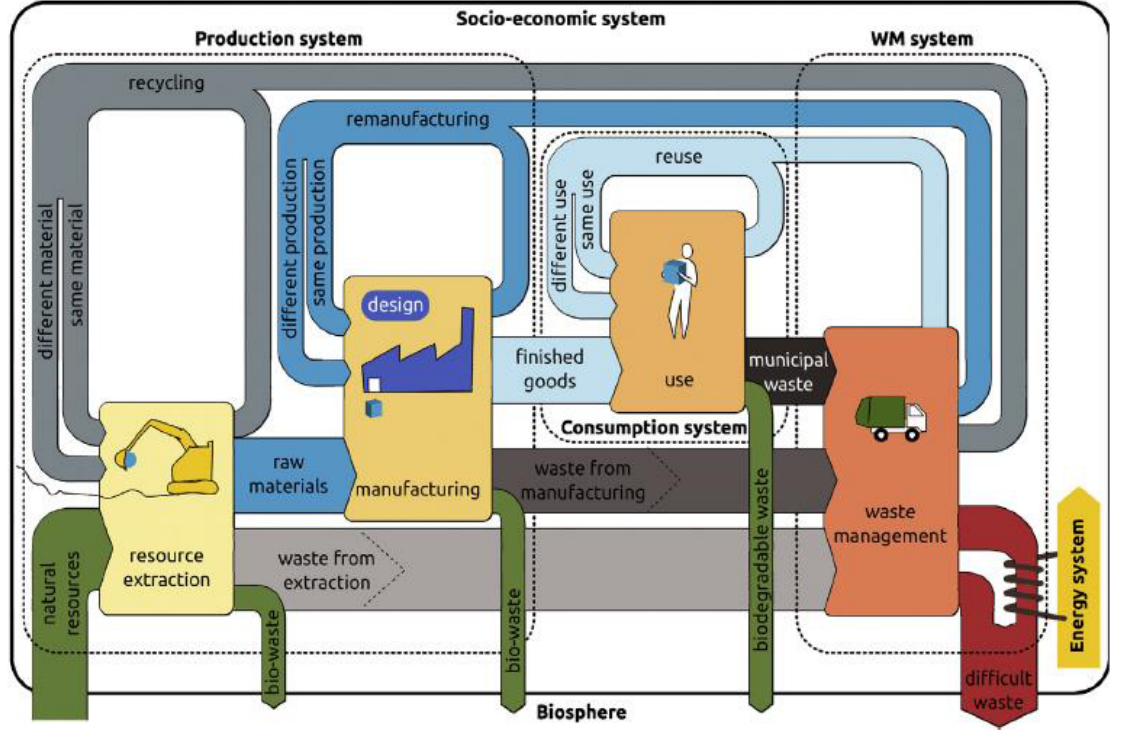
Figure 4. A modeled scheme of CE and ES routes, under an integrated flow-chart of inter-organizational processes. Source: [83], p. 348.